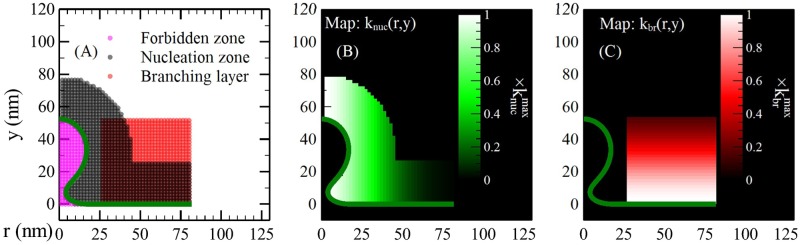
Spatial distribution of branching and spontaneous nucleation.(A) Branching and spontaneous-nucleation layers, and the forbidden zone, defined as the space inside the membrane where the filaments cannot penetrate. (B) The Gaussian nucleation function, for knuc(r, y), Eq. (S33), defined in the black layer in (A). (C) The Gaussian branching function for kbr(r, y), Eq (3), defined in the red layer in (A).